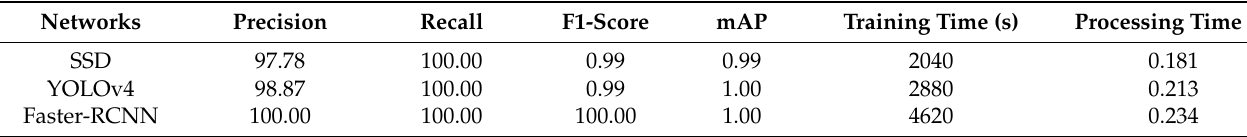
Table 2. Performance of each detection